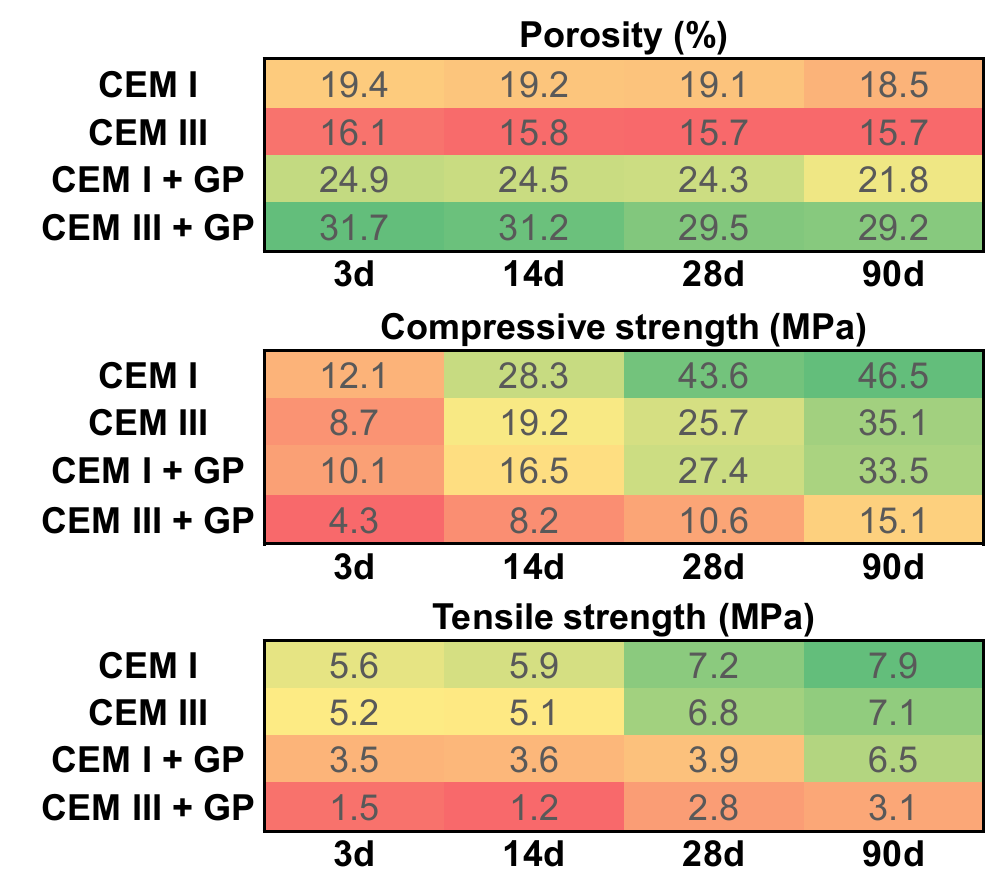
Figure 9. Porosity, and compressive and tensile strengths of mortars used. To investigate the pozzolanic reaction of GP with portlandite (CH), a thermogravimet- ric (TG) analysis is conducted at 90 days. Figure 10 shows the three main phases formed in mortars with CEM I and CEM III. The mortar with CEM III has less portlandite and calcite (CC) amounts than CEM I mortar does. This is due to the activated pozzolanic reaction of the blast furnace slag present in the CEM III cement. Nevertheless, in the case of mortars with GP, the two peaks related to portlandite and calcite are reduced, showing the consumption of CH by GP to produce additional CSH hydrates [24]. An increase in the first peak is observed. Indeed, the three phases correspond generally to three processes according to [89,90]. The first band below 200 ◦ C is due to the loss of free water as well as the dehydration of calcium silicate hydrate (CSH), ettringite (A Ft ), calcium monosulfo- aluminate, hemicarboaluminate, or calcium monocarboaluminate (all these material phases are denoted as A Fm ). The second peak around 400–500 ◦ C is contributed to the dehydrox- ylation of portlandite (CH), while the decarbonization of calcium carbonates (CC) takes place at 700–800 ◦ C. From dTG patterns, the A Ft and A Fm material phases are difficult to dissociate, as the corresponding bands are large, and the decomposition temperatures of these phases are very narrow and overlay each